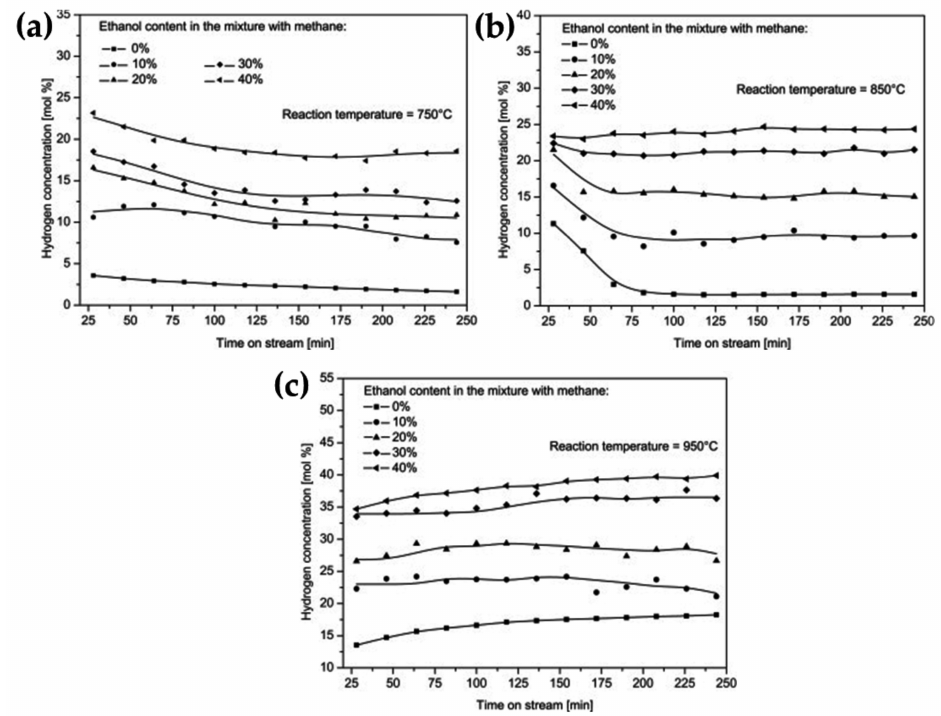
Figure 15. Effect of adding different amounts of ethanol to the CMD reaction at ( a ) 750 ◦ C, ( b ) 850 ◦ C, and ( c ) 950 ◦ C; reprinted with permission from ref. [109]. Copyright 2012